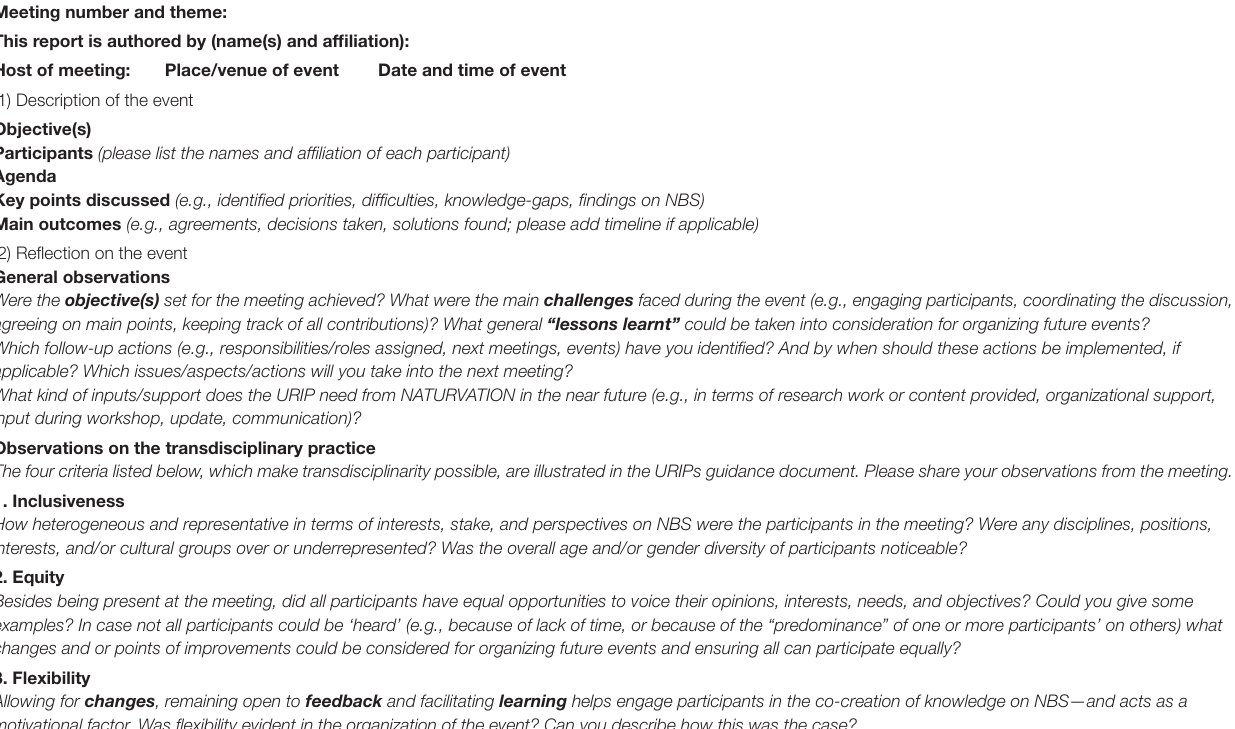
TABLE 4 | The template of the summary report provided to URIPs coordinators in June